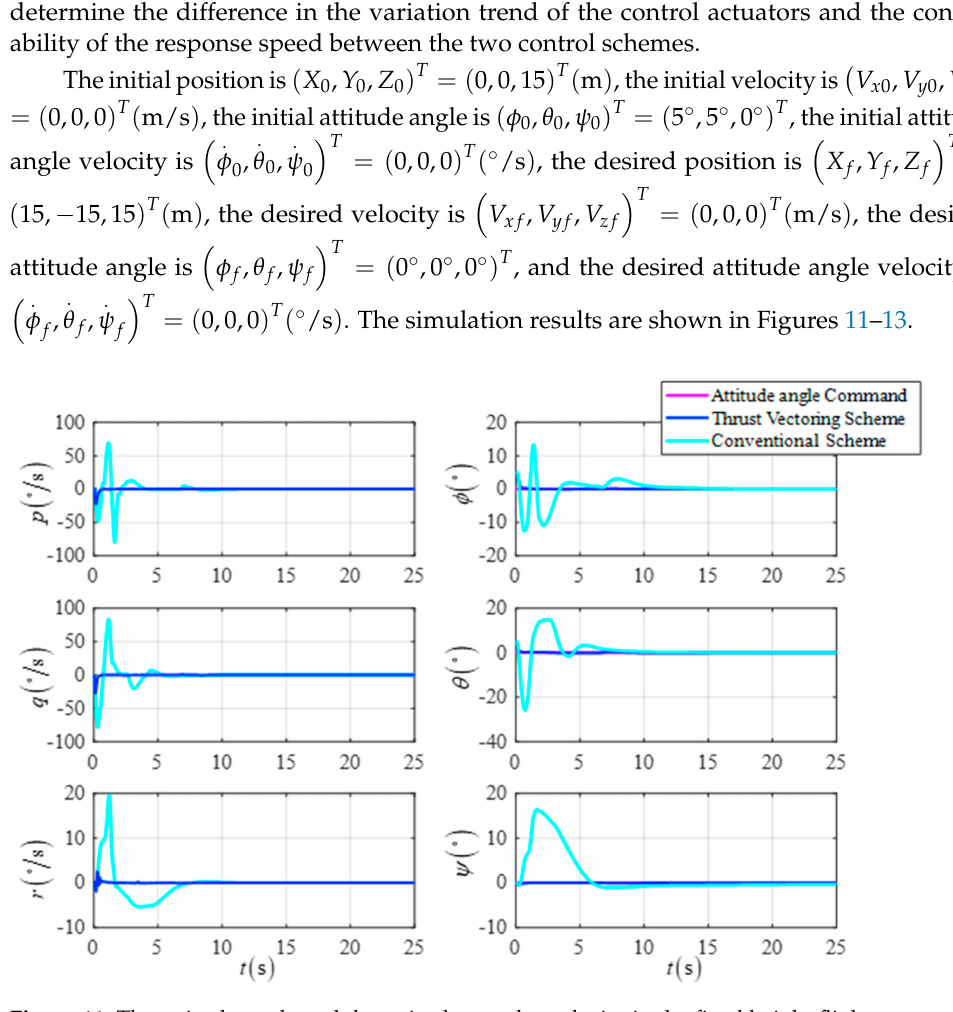
Figure 11. The attitude angle and the attitude angular velocity in the fixed height